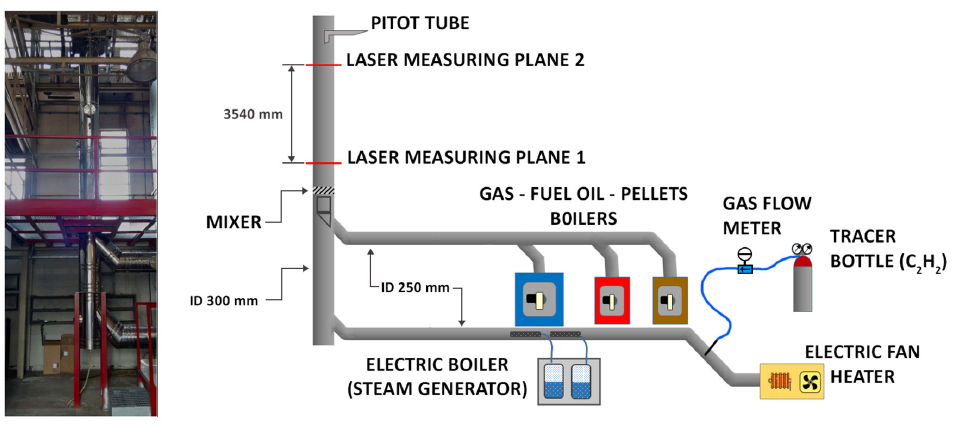
Figure 2. General layout of the stack simulation facility used in this